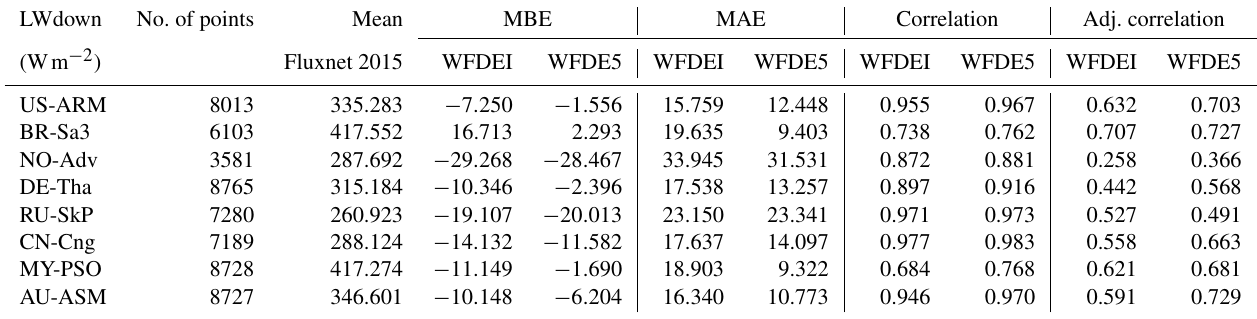
Table A14. LWdown metrics for each FLUXNET2015 site: WFDEI versus FN2015 and WFDE5 versus FN2015 at 3-hourly time steps.